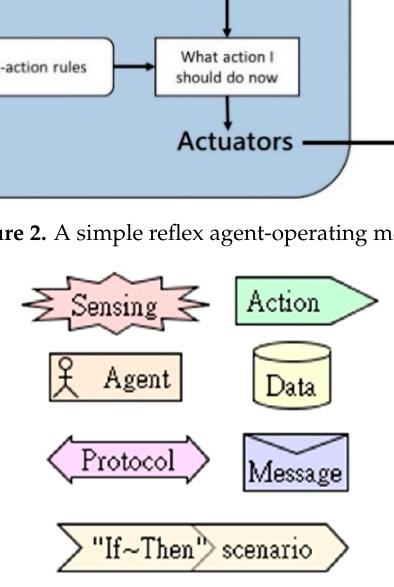
Figure 3. Graphic symbols for intelligent agent systems.